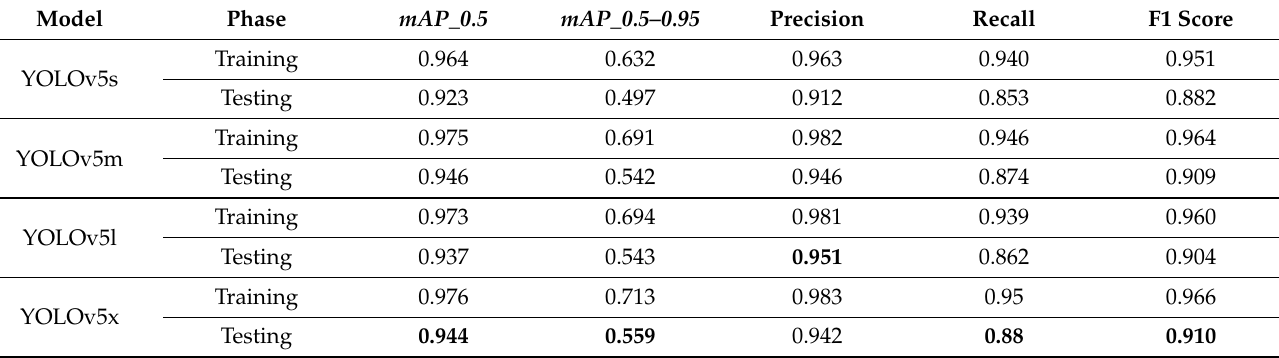
Table 6. YOLOv5 Insect Model results for